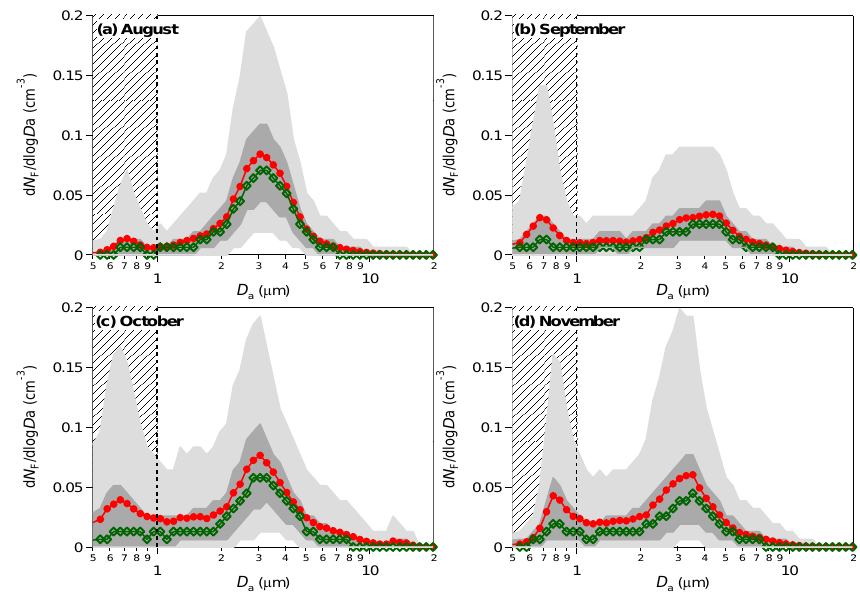
Fig. 11. Average FBAP number size distributions for each month of the measurement period (plots analogous to Fig. 10): (a) August, (b) September, (c) October, (d)